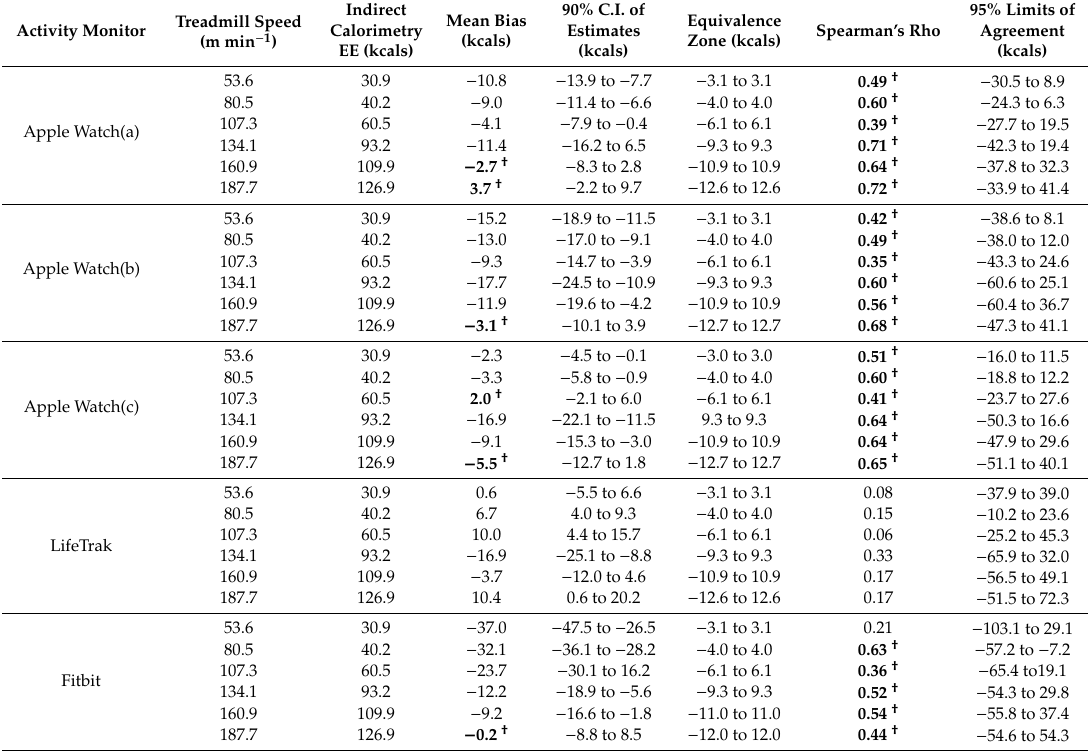
Table 2. Agreement scores in energy expenditure compared to indirect calorimetry across various treadmill